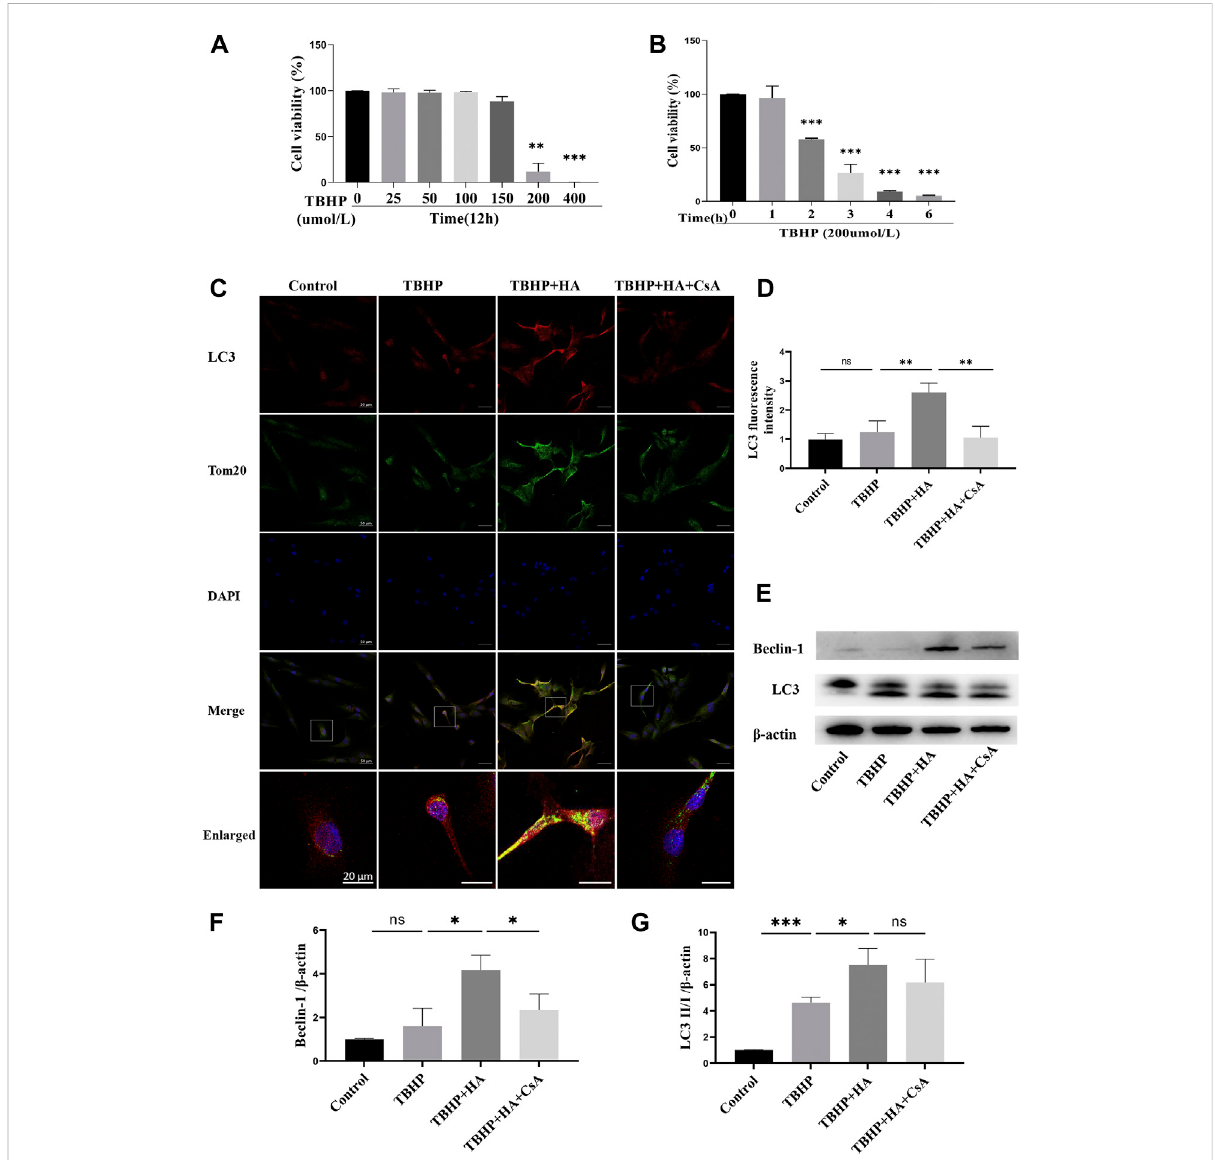
blot. Data are represented as the mean ± SD. ns, not signi fi cant, * p < 0.05, ** p < 0.01, *** p < 0.001. Scale bar: 50 or 20 μ m n =